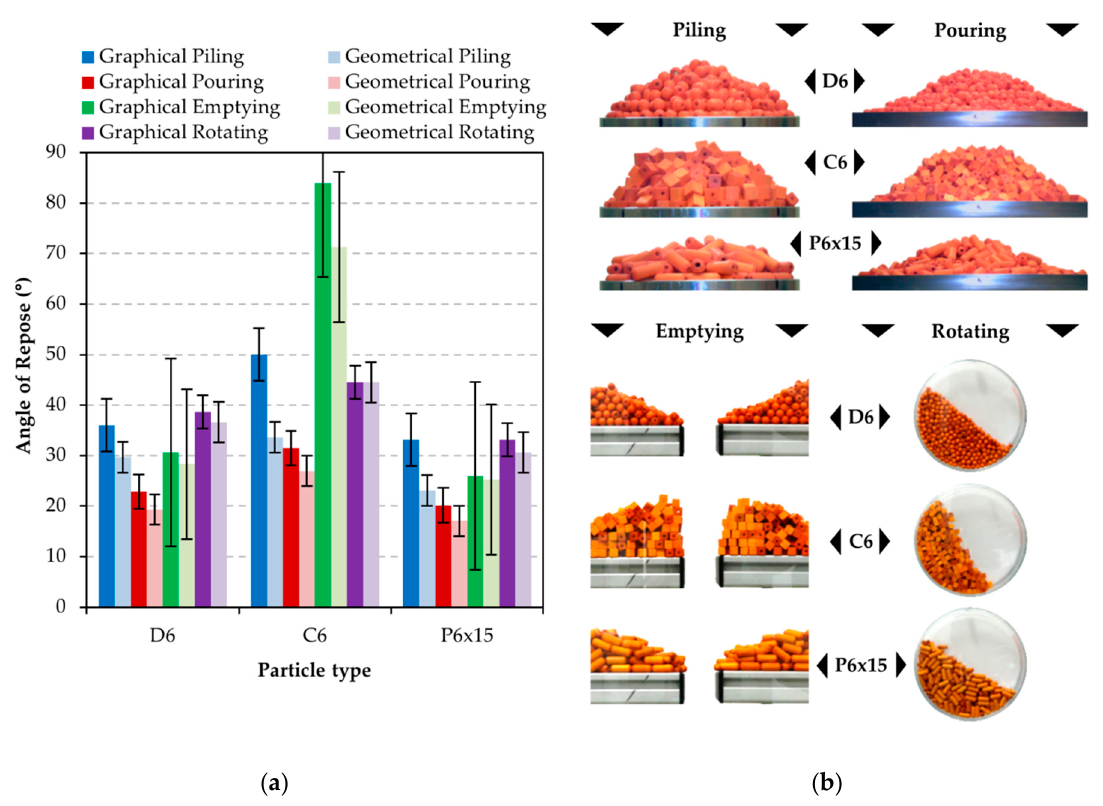
Figure 7. Angle of repose calibration: ( a ) AoR experimental results comparison; ( b ) AoR experimental results.